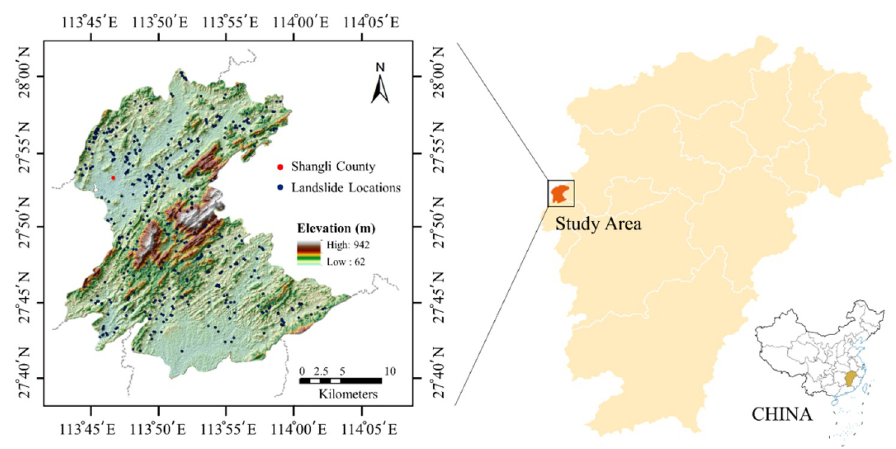
Fig 1. Overview of the study